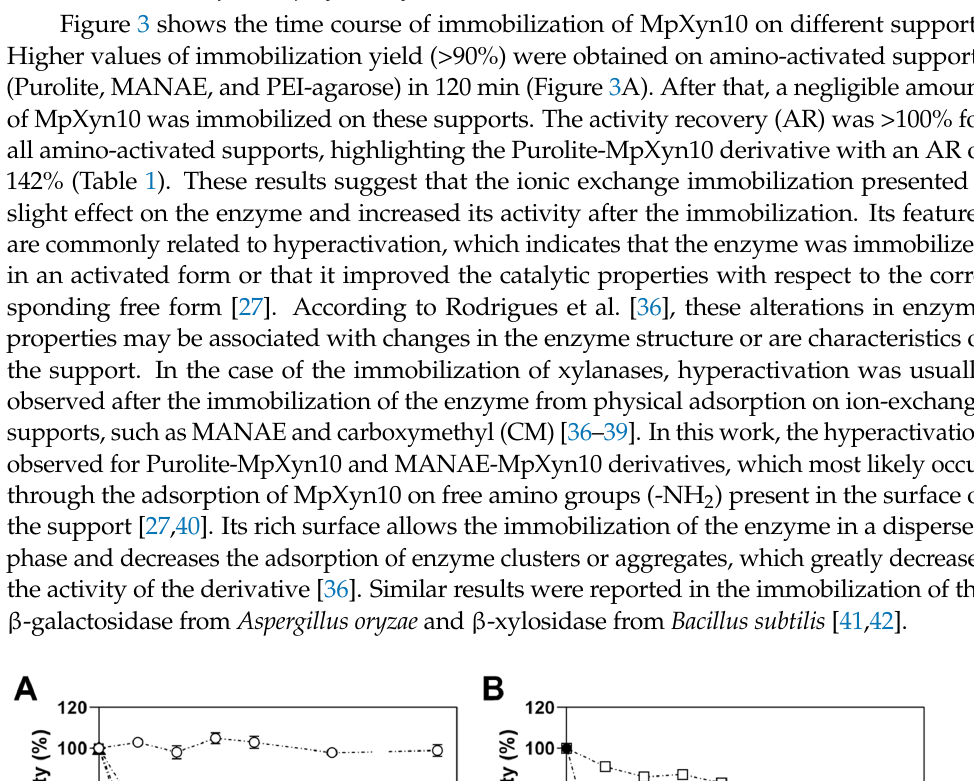
), PEI-agarose (cid:35)